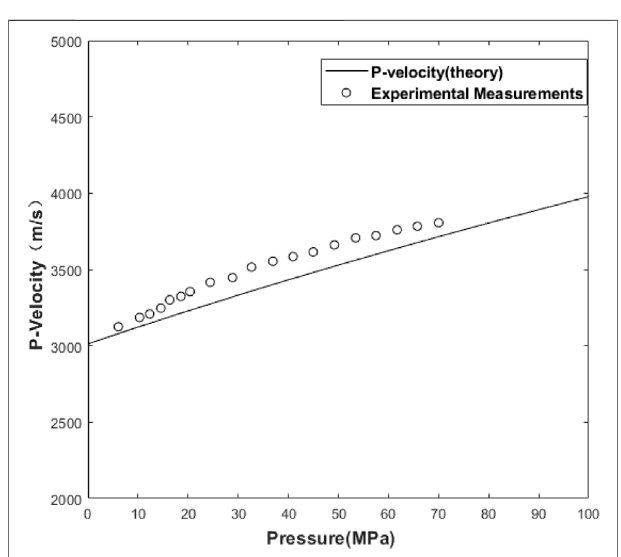
FIGURE2| Velocities(solidline)ofthelongitudinalmode asafunctionof pressure based on the experimental measurements (circles) of hydrostatic pressure (Winkler and Liu, 1996) for Portland